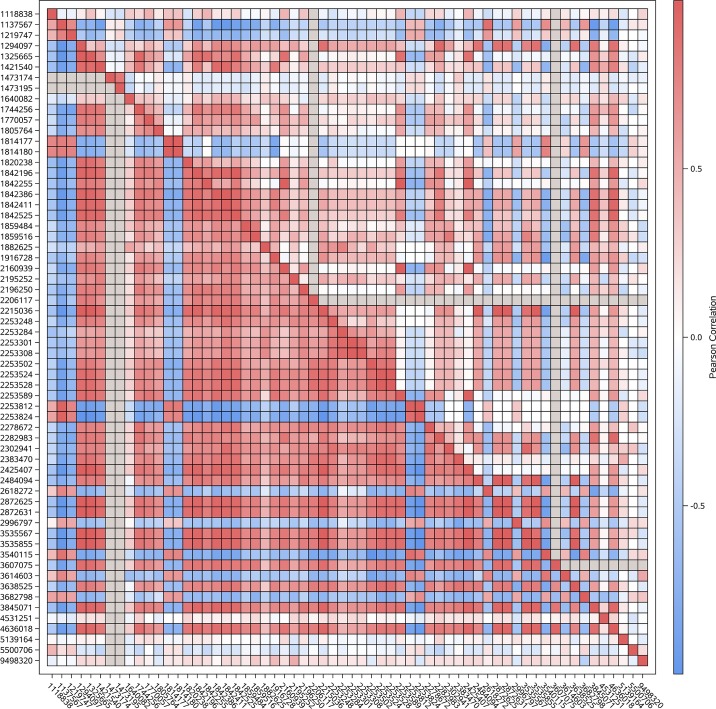
Heat map depicting the linear correlation between genotypes across the variants associated with scouting behavior located on LG12 (NC_007078.1); location in bp is denoted by the rightmost number and gray color indicates no genotypic variation among all bees within one behavior group.